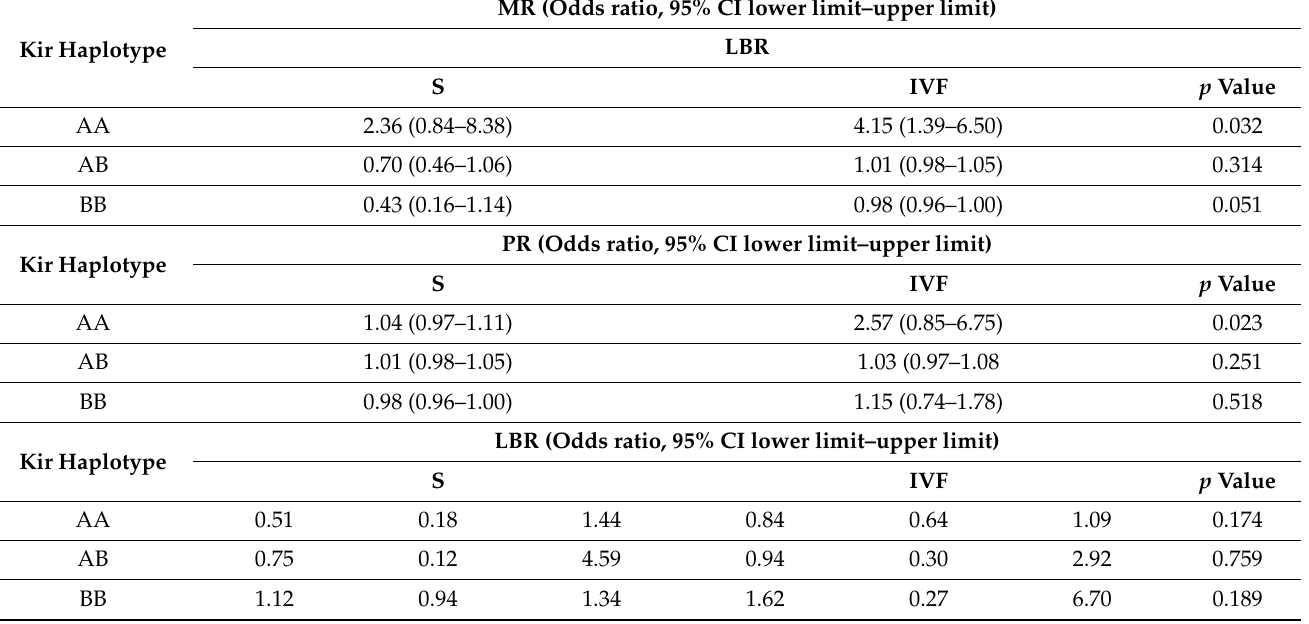
Table 5. Comparison of reproductive depending on the mode of achieving a pregnancy for the patients included in the analyzed